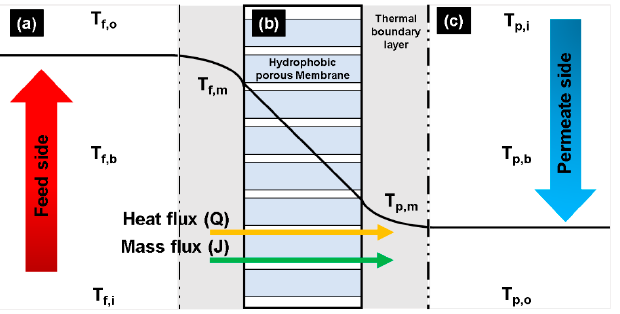
Figure 1. Schematic of heat/mass transfer through a hydrophobic porous membrane used in a DCMD process: ( a ) evaporation in the feed side, ( b ) transportation of water vapor across the membrane pore, and ( c ) condensation of water vapor in the permeate side.